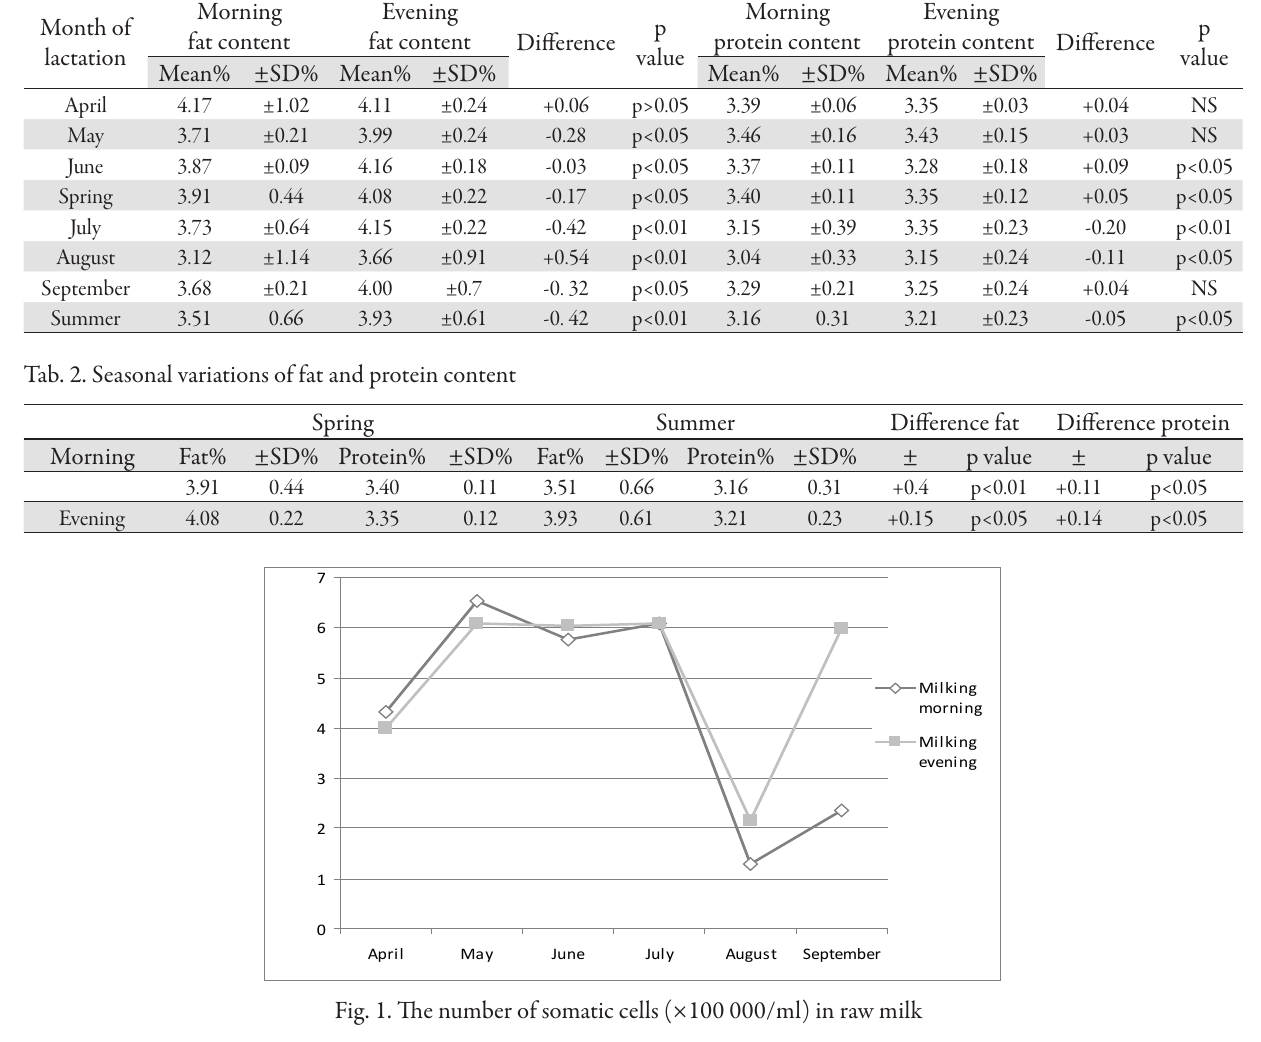
Tab. 1. Milking-to-milking variations in fat and protein content Month of